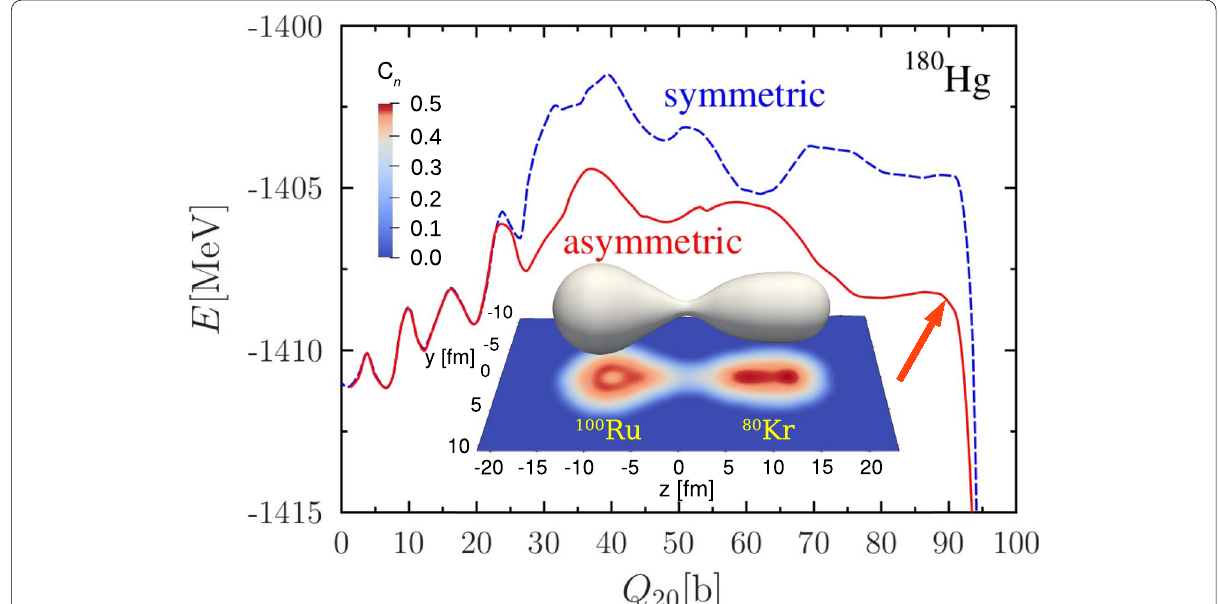
Fig. 14 Potential energy profile along the symmetric (dashed line) and an asymmetric (solid line) fission pathway of 180 Hg. Equal density surface at half-saturation density of 0.08 particles/fm − 3 and the projection of neutron NLF are shown for a quadrupole shape just before scission in the asymmetric fission valley (marked with the red arrow). The figure is adapted from